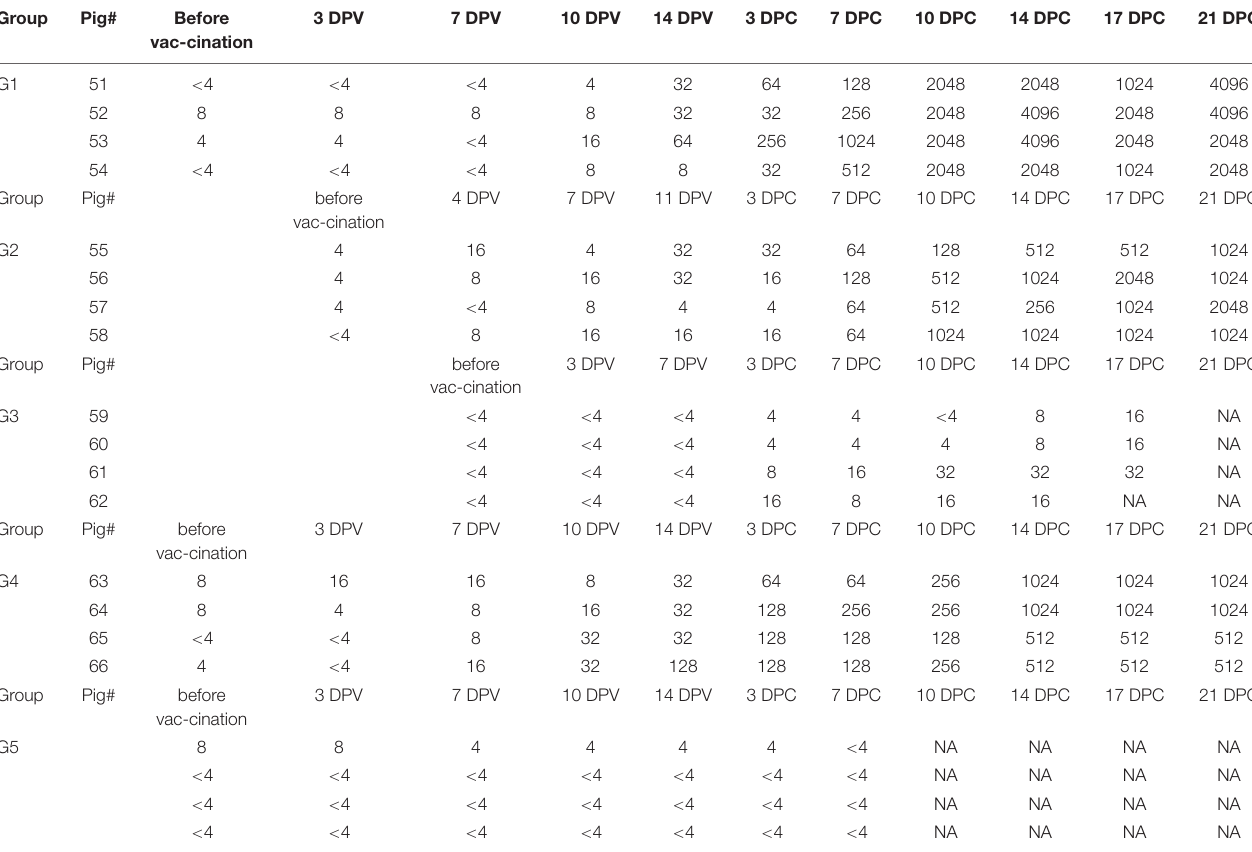
TABLE 3 | Single-dose vaccination and classical swine fever virus (CSFV)-neutralizing antibody titers before and after viral challenge.